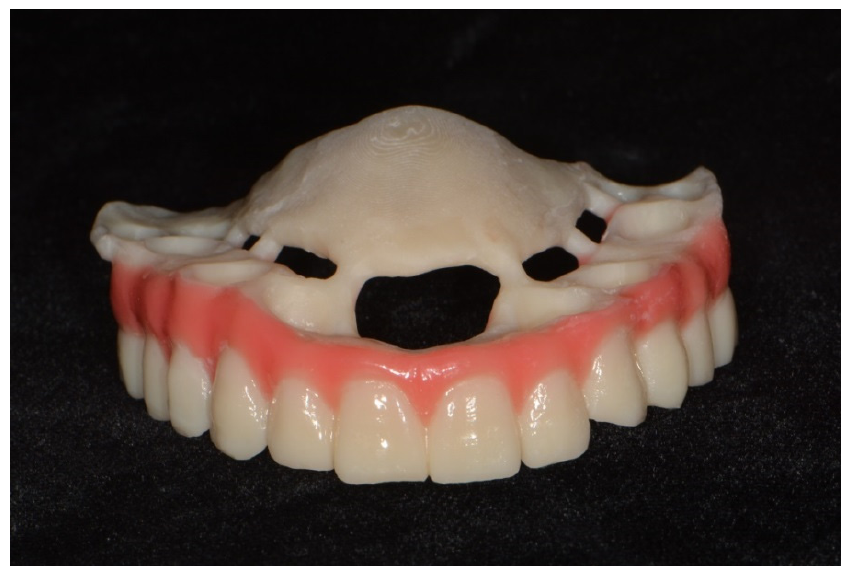
Figure 3. ( A ) Image fusion by matching resin markers present on the intraoral scan and CBCT. ( B ) Virtual implant planning. ( C ) Designed guide for the placement of six dental implants.